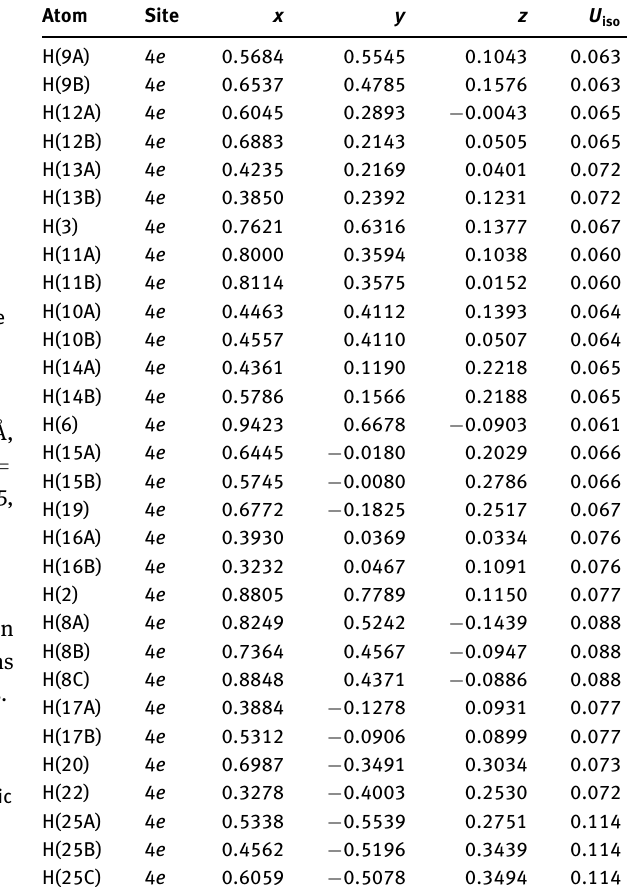
Table 2: Fractional atomic coordinates and isotropic or equivalent isotropic displacement parameters (Å 2